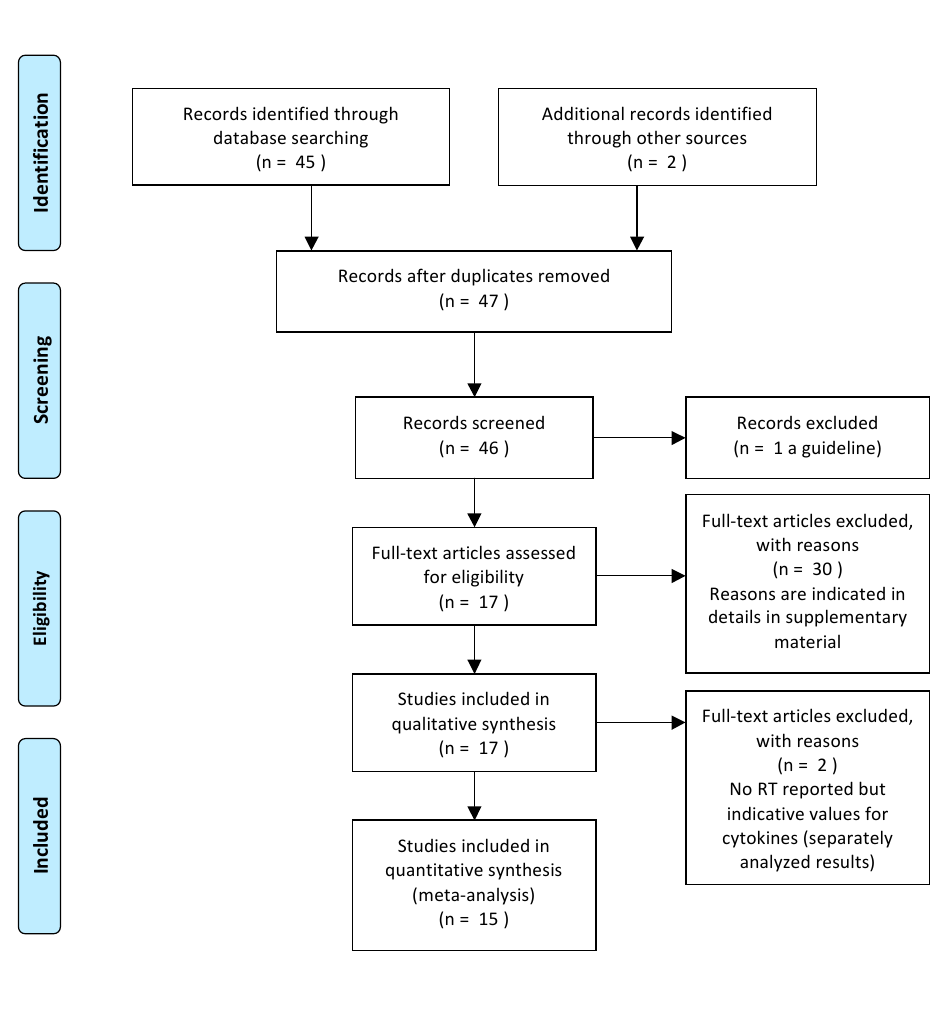
Figure 2. PRISMA flowchart reporting the searching strategy adopted in this study.